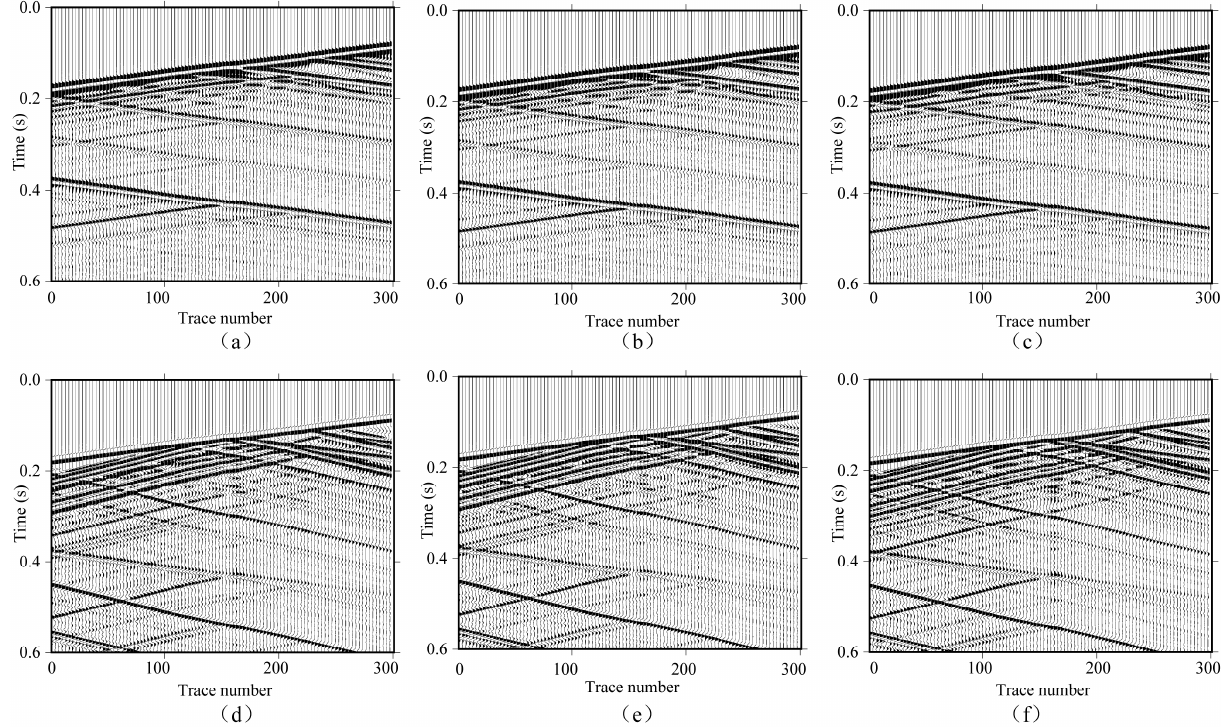
Figure 3. ( a – c ) The vertical component of time-lapse cross-well shot gathers with the deep source position (900 m) from the baseline survey, first-repeat, and second-repeat surveys, respectively. ( d – f ) as in ( a – c ) but displaying the horizontal components instead.